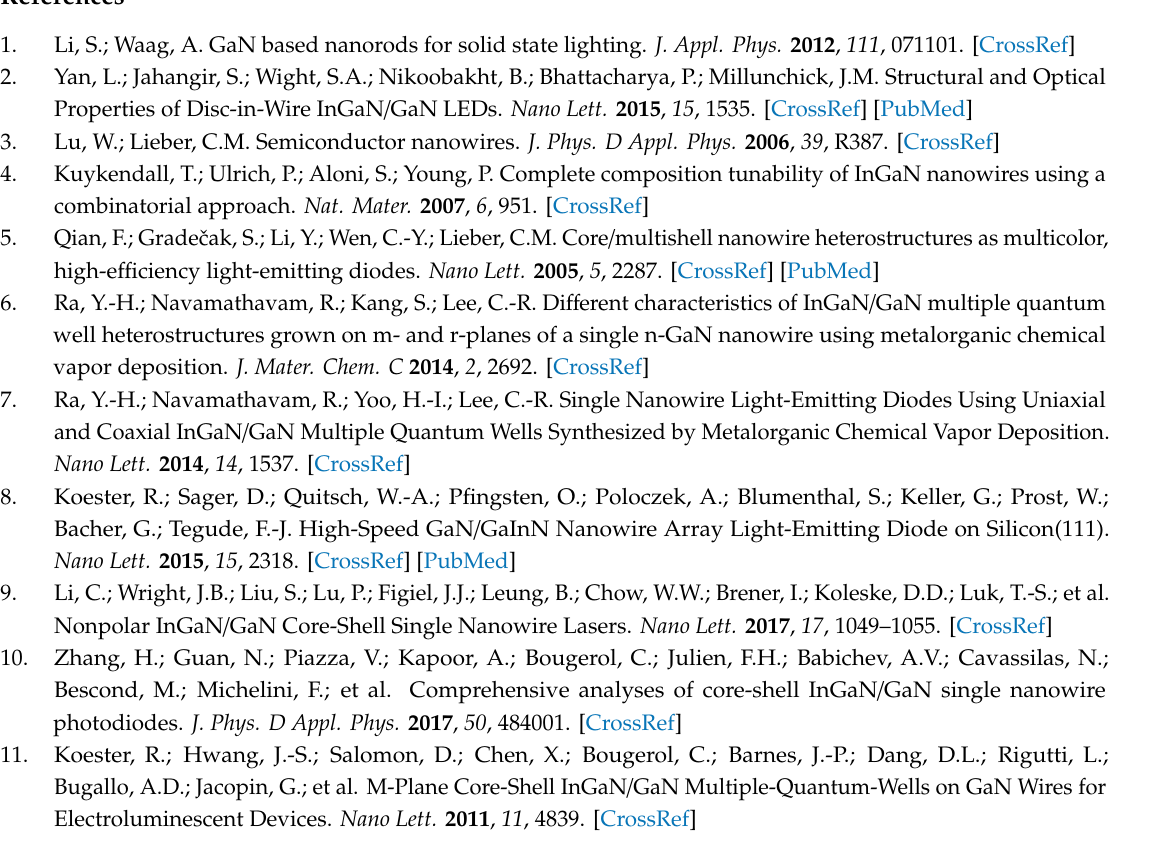
Figure S1: EDS linear scan along the NW axis, Figure S2: XRF maps of Au-L and Ag-K α , Figure S3: Linear scans of In and Ga XRF peaks performed along the NW axis and NW diameter, Figure S4: PL spectrum of an ensemble of NWs, Figure S5: Contour plots of the strain components on the NW